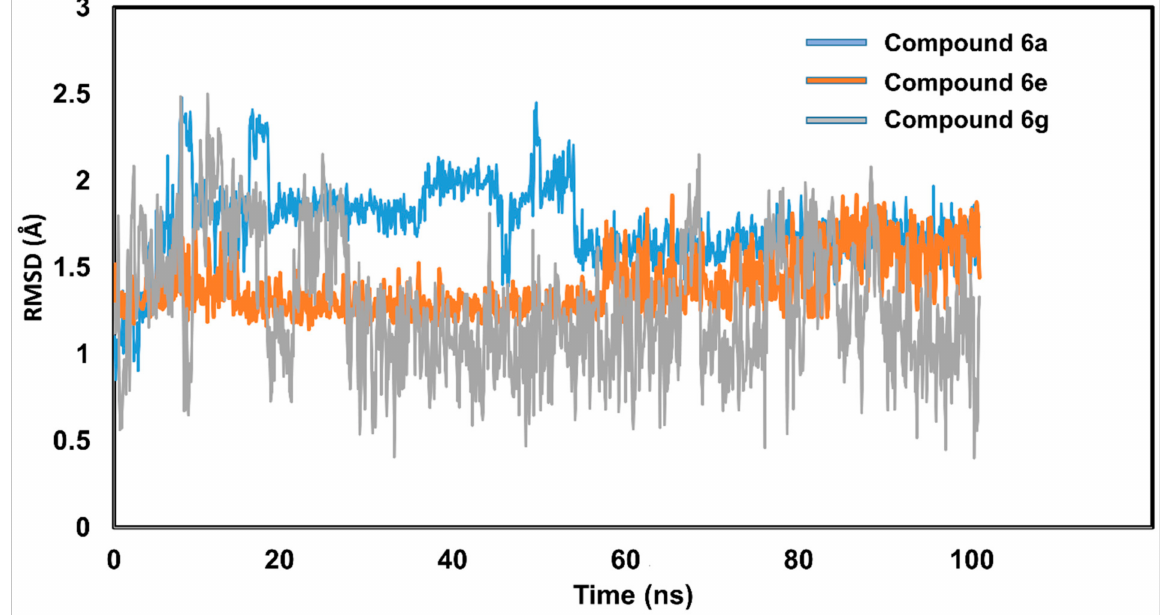
Figure 9. Compounds 6a , 6e , and 6g ’s stability patterns are illustrated. Compound 6a ’s RMSD pattern is shown by a blue trajectory, compound 6e ’s RMSD pattern is represented by a brown trajectory, and compound 6g ’s RMSD pattern is represented by a gray